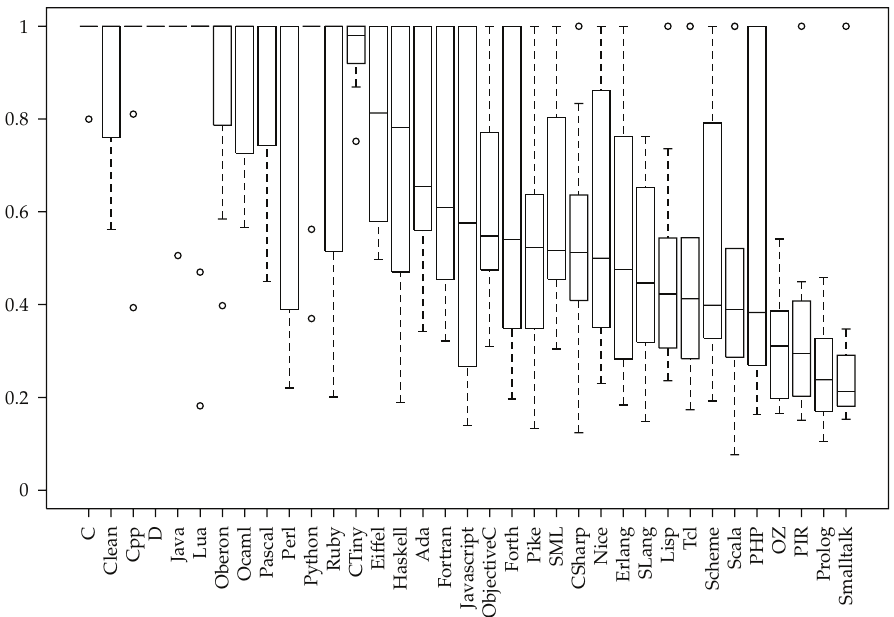
Figure 4: E ffi ciency of each language on the benchmark problems.